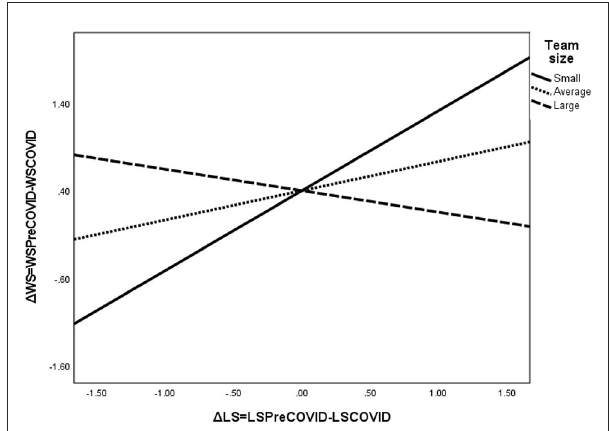
FIGURE2 The interaction effect between changes in empowering leadership and team size on work satisfaction. 1 EL, change in empowering leadership due to COVID-19; 1 WS, change in work satisfaction due to COVID-19; ELPreCOVID, empowering leadership before the